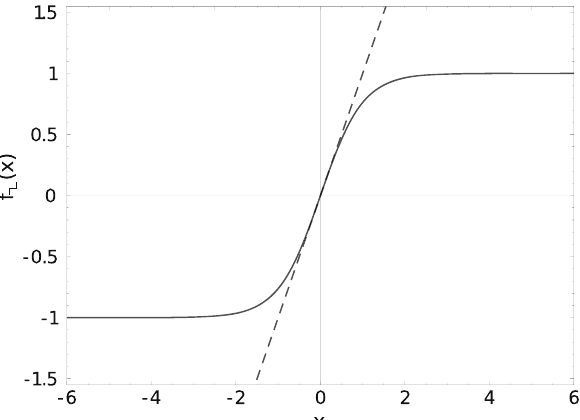
Fig. 2 Hyperbolic tangent (solid curve) and linear (dashed curve) acti- vation functions